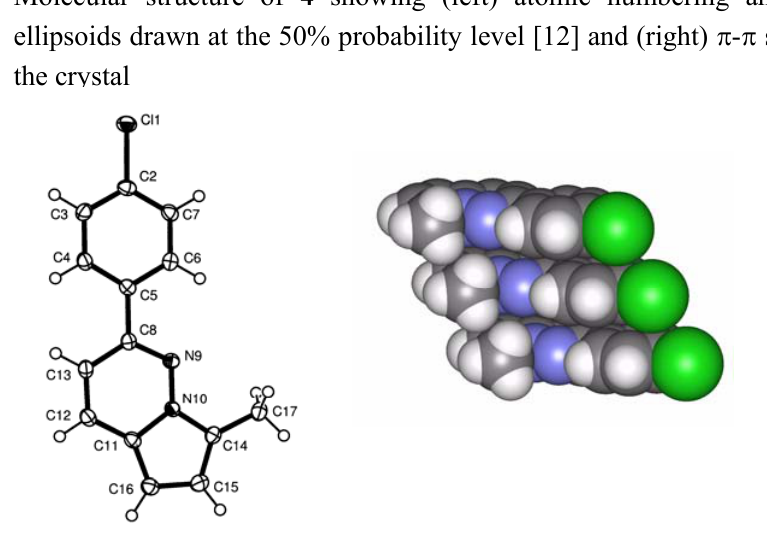
Figure 1. Molecular structure of 4 showing (left) atomic numbering and thermal ellipsoids drawn at the 50% probability level [12] and (right) π - π stacking in the